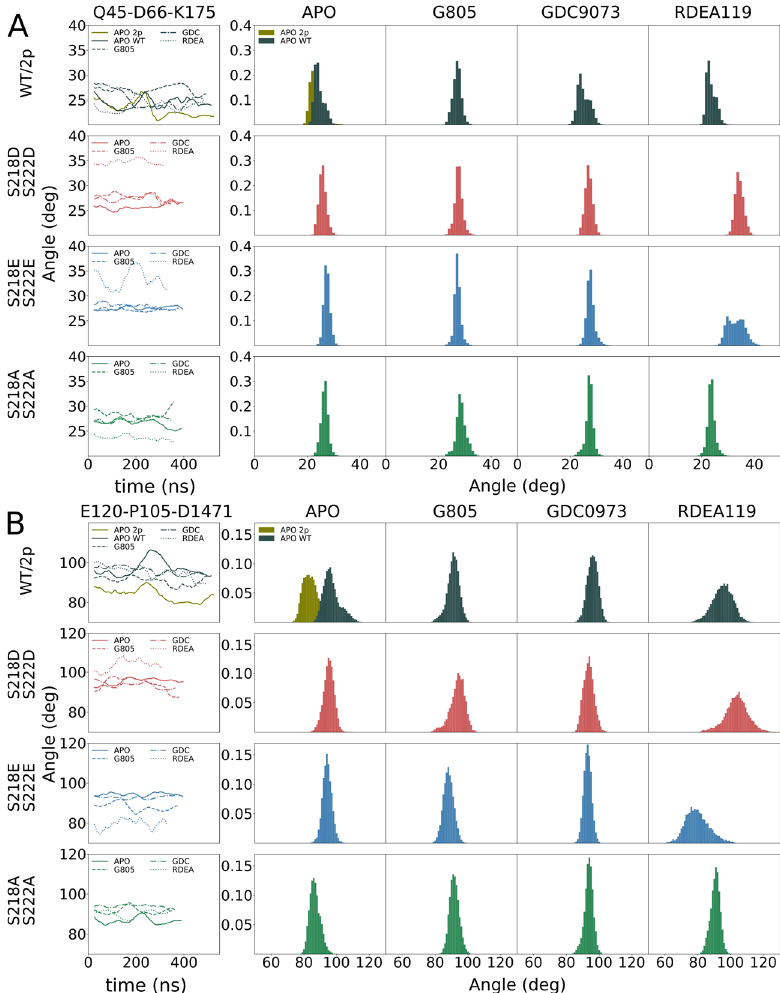
Figure 4. Structural dynamics of phosphorylation-mimetic MEK1 mutants: ( A ) MEK1 A-helix motion as characterized by a change in angle with respect to time where the observed angle is defined by Q45, D66, and K175 C α atoms. The average angle over time for three systems (APO, G805 bound, and GDC0973 bound) suggests that Glu/Glu and Ala/Ala mutants adopt a narrower range of conformations compared to both Asp/Asp mutants and WT MEK1. ( B ) Similarly, MEK1 α C-helix motion is tracked by measuring the angle defined by α C-helix residues E120, P105, and hinge residue D147. Signature structural rearrangements that occur during kinase activation as expressed through α C-helix in/out conformations appear greatest between unphosphorylated and phosphorylated WT APO MEK1.